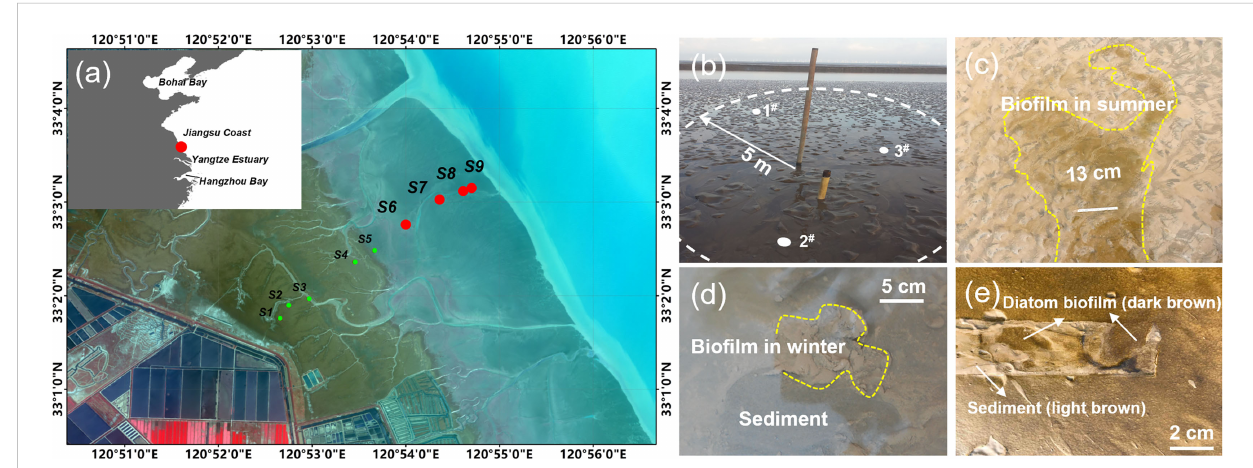
FIGURE 1 The sampling sites. (A) The location of the four sampling sites, among the nine long-term observation sites previously established, numbered of S6 to S9 from land to sea, on the intertidal fl ats in Jiangsu Coast. Inset - position of the Jiangsu Coast. (B) A site marker set at S9, in a radius ( R =5 m) around which three points were randomly selected for sampling. (C) Bio fi lm formed a patch on the surface of the bottom bed (photos taken at S6 in summer). A paper ruler was place on the bed (13 cm in length) as a scale marker. The bio fi lm in winter was featured by small fractions of mushroom-like architecture, and in the color of gray and white (D) , while a smooth and glue-like thick layer in dark brown was observed in summer, with diatom as the dominant (E) . Removal of the ruler uncovered the underlain sediment layer which showed in light brown (E)